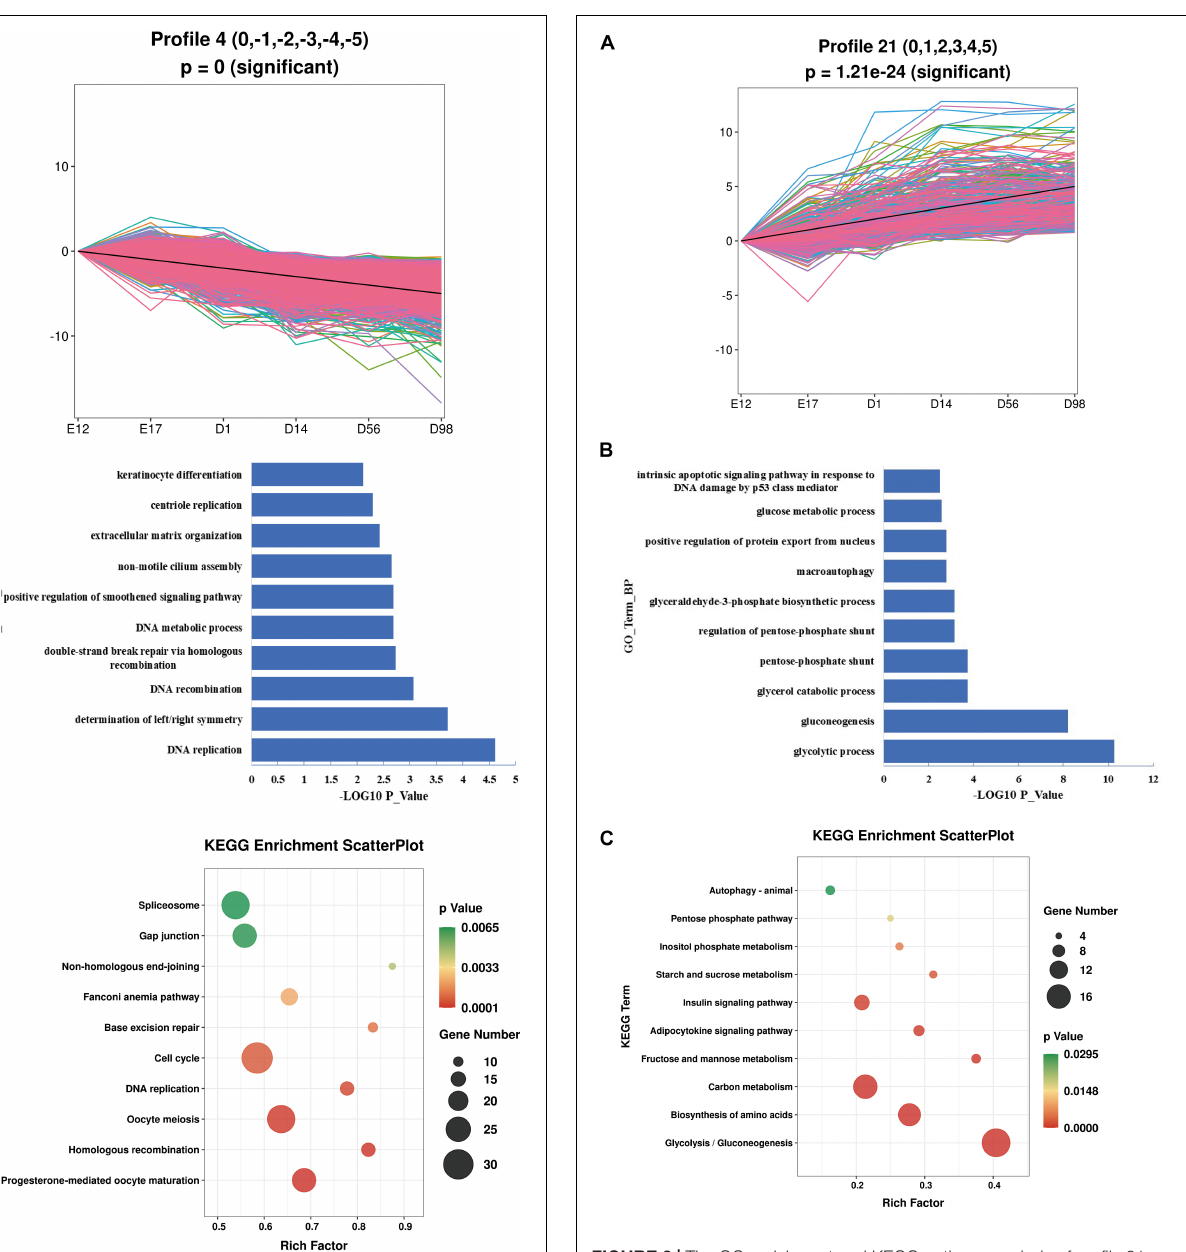
FIGURE 3 | The GO enrichment and KEGG pathway analysis of profile 21. (A) Details of profile 21. (B) The top 10 biological processes in profile 21. (C) The top 10 KEGG pathways in profile